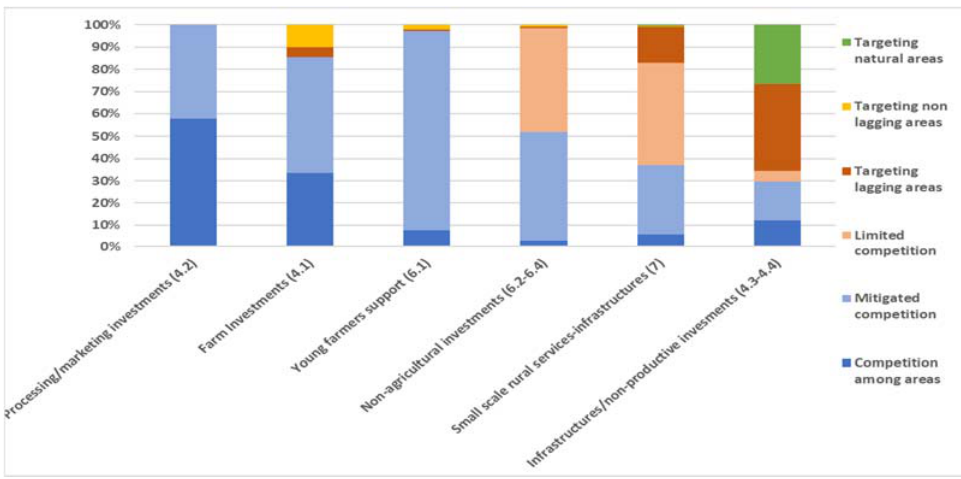
Figure 11. Distribution of committed expenditures by different modes of project selection in each type of investment support. Source: authors’ elaborations from the data base of funded investment projects.